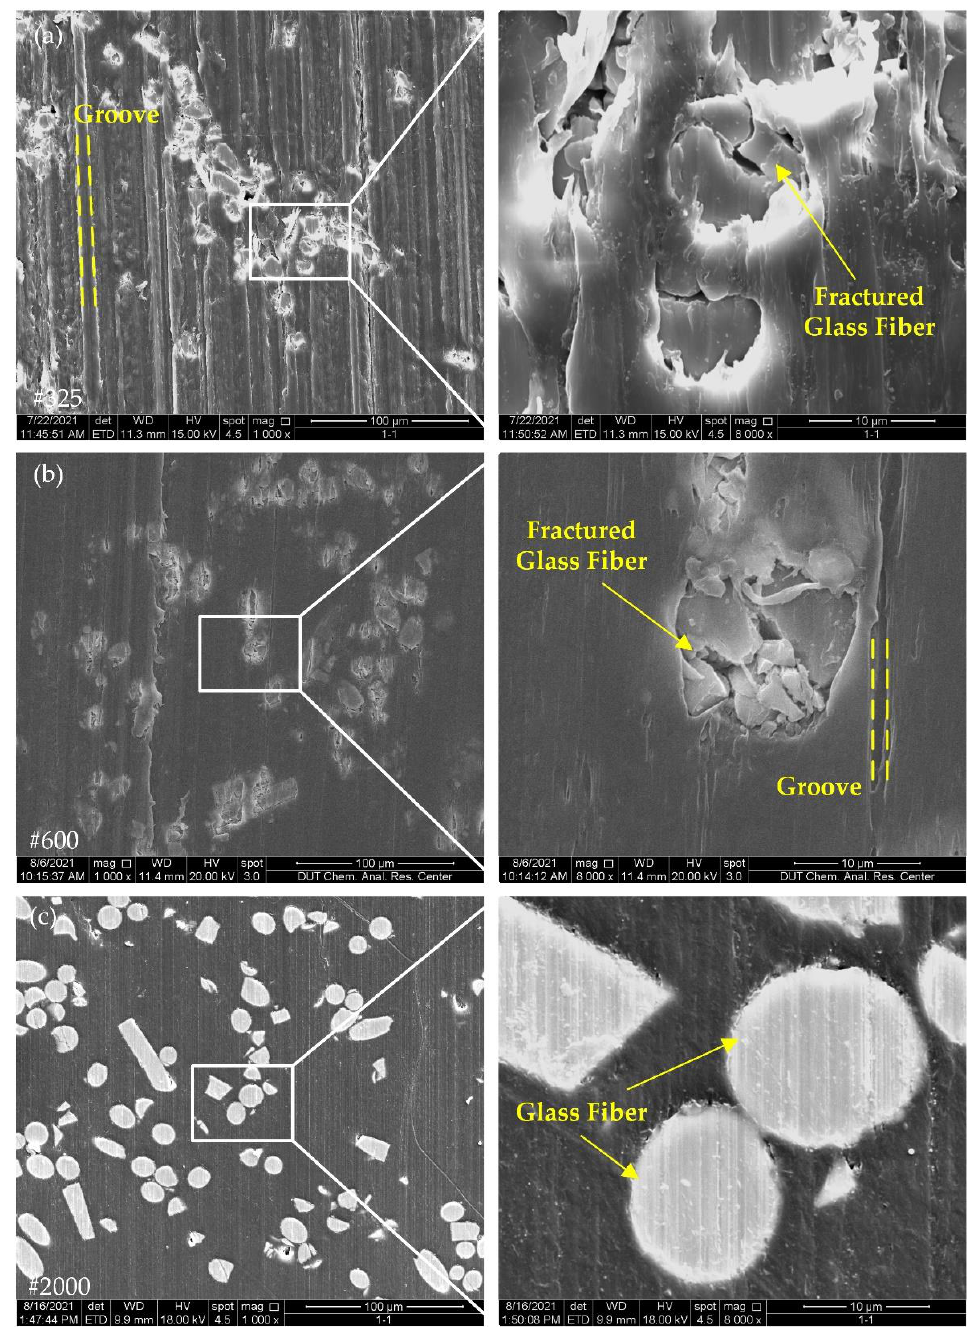
Figure 10. Surface morphology of GF30/PEEK with different grinding wheels: ( a ) grit size #325; ( b ) grit size #600; ( c ) grit size #2000.